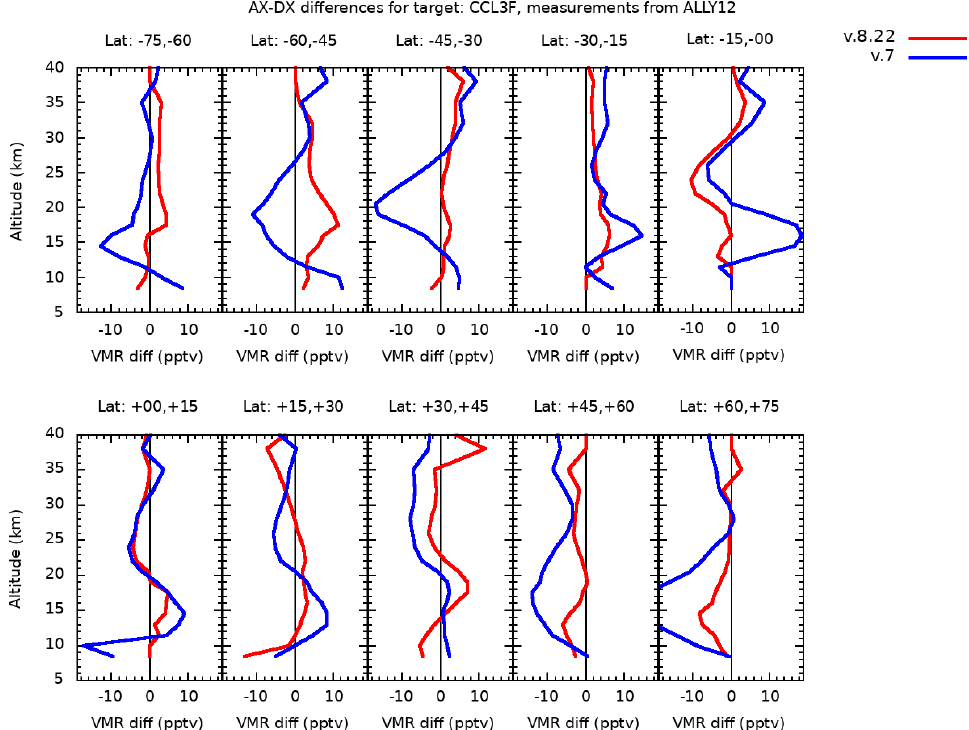
Figure 4. CFC-11 ascending–descending average difference profiles for V7 (blue) and V8 (red) MIPAS/ESA products. Averaging extends to the measurements acquired in the month of December of the years 2006 to 2011 (OR part of the mission). The different panels show different latitude bands as indicated on the top of the panels.